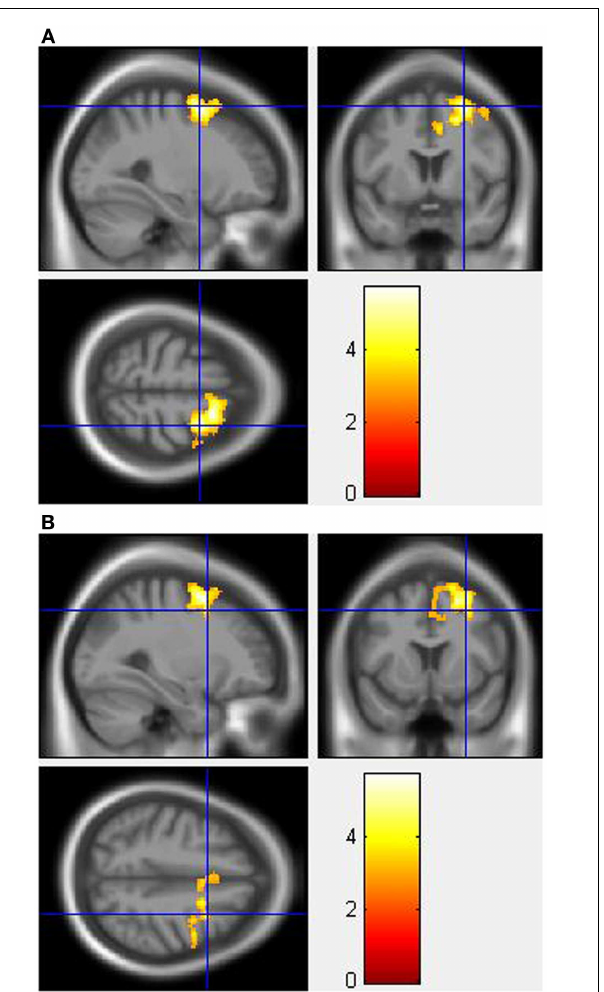
FIGURE 1 |Whole-brain two-sample t -test results for the incongruent condition showing pre-drug MA-dependent > control group differences in activation of: (A) the right superior frontal gyrus [peak voxel MNI co-ordinates (mm): (28, 4, 60); T 31 = 5.73, p < 0.05 cluster-corrected], and (B) the right middle frontal gyrus [peak voxel MNI co-ordinates (mm): (30, 10, 46); T 31 = 3.84, p < 0.05 cluster-corrected] .The scale represents the color (from red to yellow) of the cluster corresponding to the increasing t -statistic.The structural image represents the IXI550 average normal brain which has been registered to the MNI152 space with corresponding inferior–superior co-ordinates.